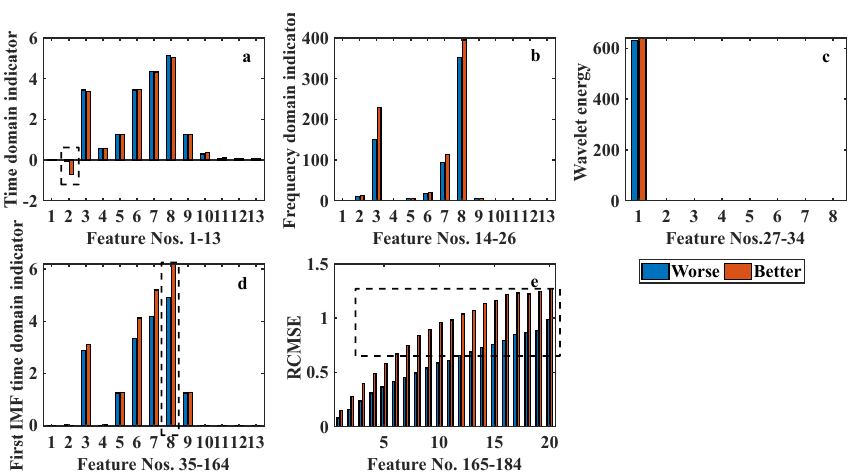
Figure 4. The extracted 184 features from ECG signals for one ‘Better’ and ‘Worse’ cases. ( a ) Time domain feature; ( b ) frequency domain feature; ( c ) wavelet energy feature; ( d ) EEMD with time domain feature; ( e ) RCMSE feature.